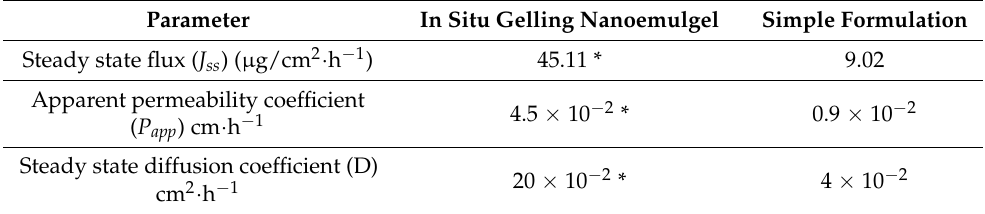
Table 1. Ex vivo permeation characteristics of naringin through sheep nasal mucosa for in situ gelling nanoemulgel and simple formulation ( n = 6 ±